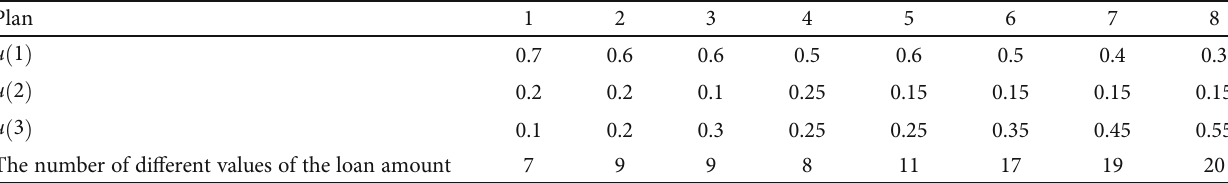
Table 5: Analysis of di ff erent results obtained by di ff erent scale coe ffi cients of the three objective